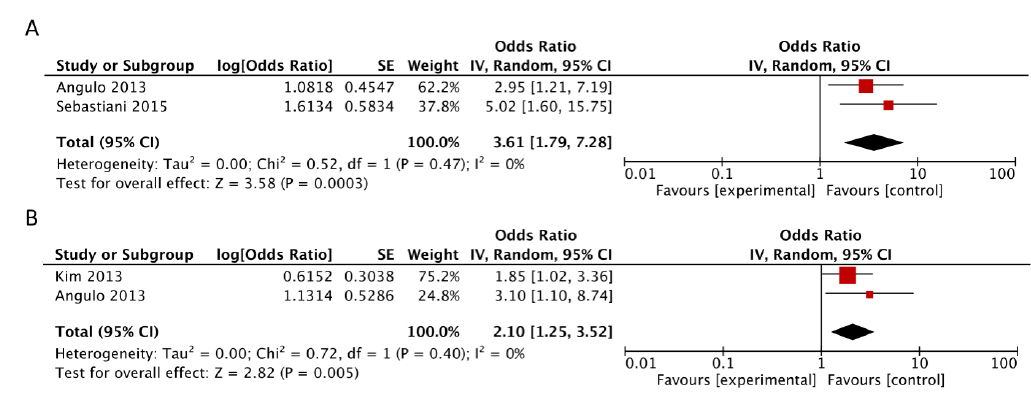
Figure 4. Forest plot of summary relative risks (RRs) of mortality ( A ) for high versus low-intermediate APRI and ( B ) for high versus low APRI.